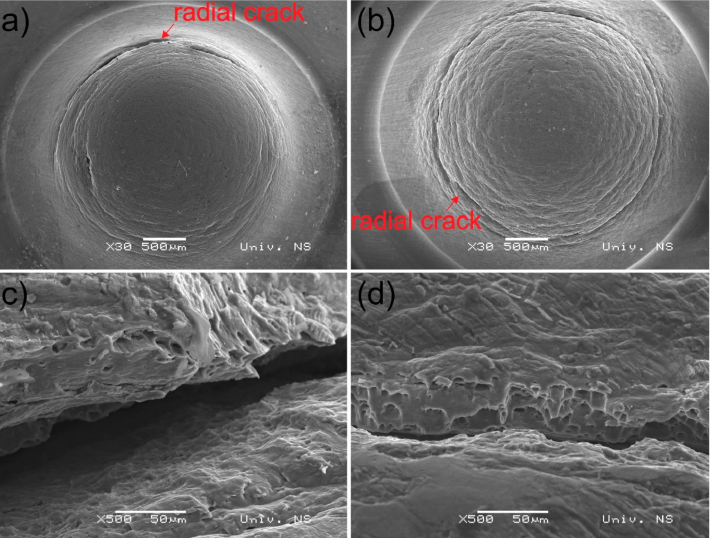
Figure 15. Scanning electron microscopy (SEM) images of the welds from the batch I after small punch test: ( a ) top view of the specimen obtained at 1500 rpm (RW1); ( b ) top view of the specimen obtained at 3500 rpm (RWA1); ( c ) higher magnification of the rupture–RW1; ( d ) higher magnification of the